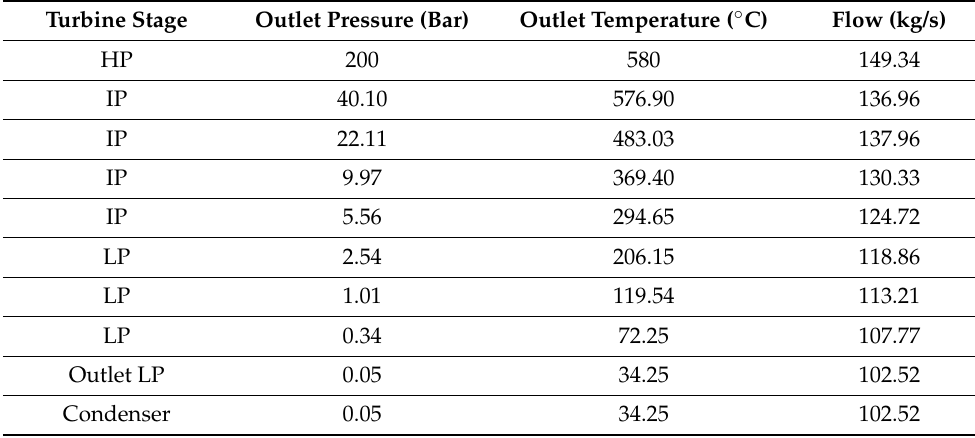
Table 2. Steam characteristics at different extraction points.